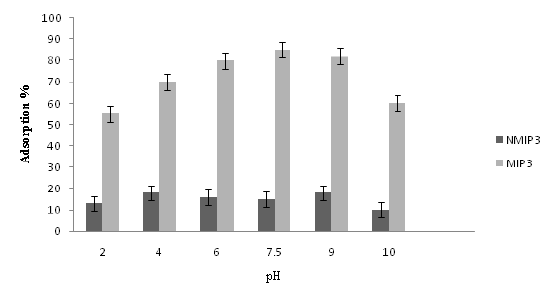
Figure 8. Effect of pH on rebinding efficiency of tramaddol. 50 mg of the imprinted polymers; sample volume: 5 mL; tramadol concentration: 50 µg L −1 ; temperature 20°C (mean±S.D., n=3)